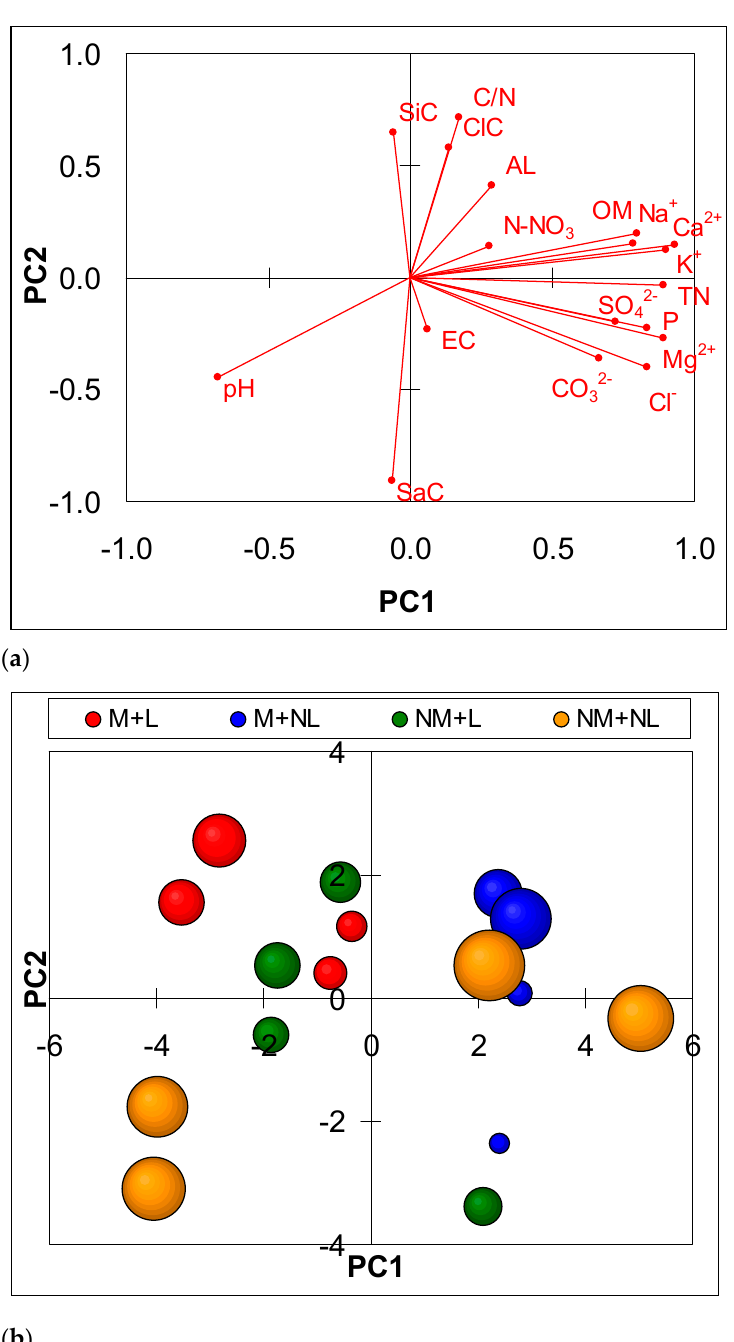
Figure 3. Loadings of the original variables (main chemical properties of soils) ( a ), and their scores on the first two Principal Components (PC1 and PC2) provided by PCA, applied to observations of the growth of Pinus halepensis Mill. in plots subjected to four treatments in the Sierra de Los Donceles forest (Liétor, Castilla La Mancha, Spain). In chart ( b ), the area of circles is proportional to the values of PC3. Legend: M + L = mulching + logging; NM + L = no mulching + logging; NM + NL = no mulching + no logging; M + NL = mulching + no logging; SaC = sand content; SiC = silt content; ClC = Clay content; EC = electrical conductivity; OM = organic matter; C = carbon; TN = total nitrogen; N-NO 3 = nitric nitrogen; P = phosphorous; K + = potassium; Na + = sodium; Ca 2+ = calcium; Mg 2+ = magnesium; Cl − = chloride; SO 4 2 − = sulphates; CO 3 2 − = carbonates; AL = active